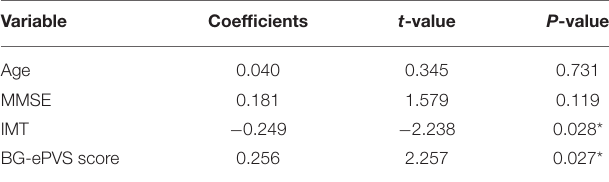
TABLE 5 | Multiple linear regression analysis of ALPS-index and other